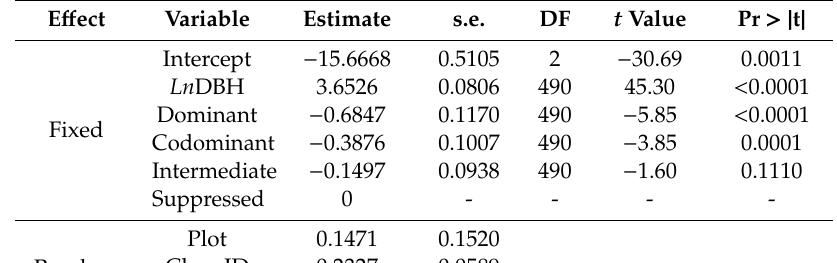
Table 5. Even-aged redwood bark thickness (BT) model. Linear mixed-e ff ects model for square-root transformed BT (mm) in each crown class as a function of DBH (mm) at age 85 years in three even-aged stands in Jackson Demonstration State Forest.